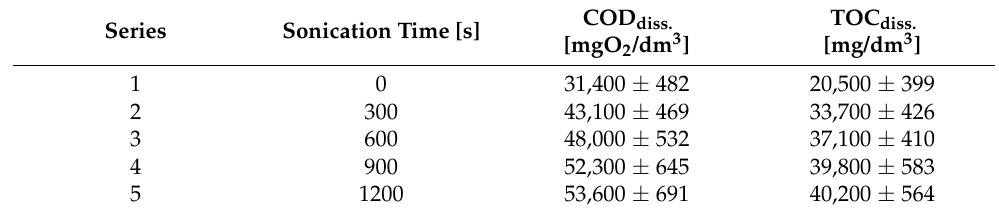
Table 4. Concentration of organic compounds in the dissolved phase in particular experimental series. COD diss. TOC diss. Series Sonication Time [s] [mgO 2 /dm 3 ] [mg/dm 3 ] 1 0 31,400 ± 482 20,500 ± 399 2 300 43,100 ± 469 33,700 ± 426 600 48,000 ± 532 37,100 ± 410 900 52,300 ±